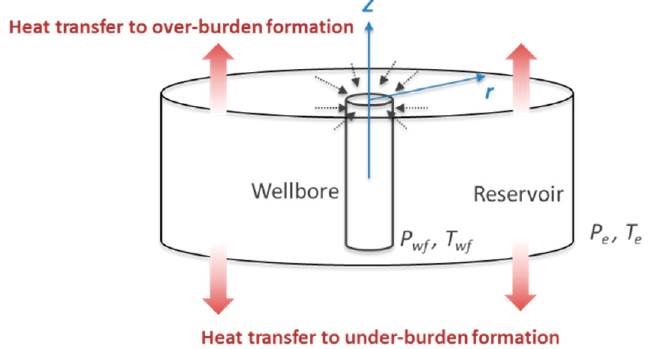
Figure 1. Schematic heat transfer of reservoir and formation where r is the radius from the wellbore, P_wf is the wellbore wall fluid pressure, T_wf is the wellbore wall fluid temperature. The steady-state energy equation for this system considers the conservation of mass and energy. The comprehensive energy-balance equation for this system can be written to this partial-differential